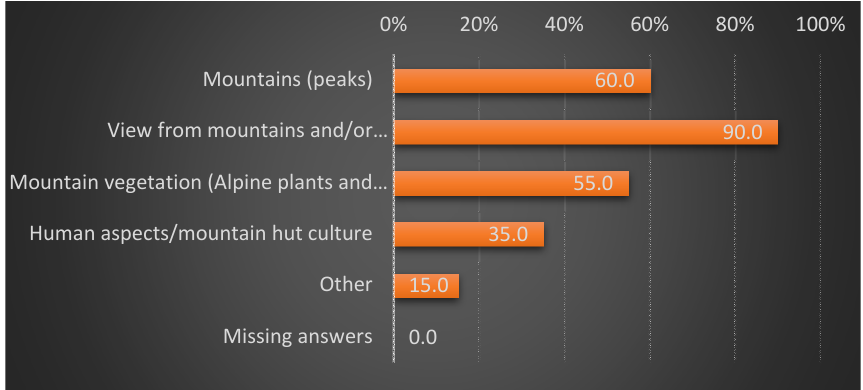
Figure 8. Visitor attractions revealed from the question: What is the most attractive feature for you in this place (and surroundings)? (Multiple answers were possible).